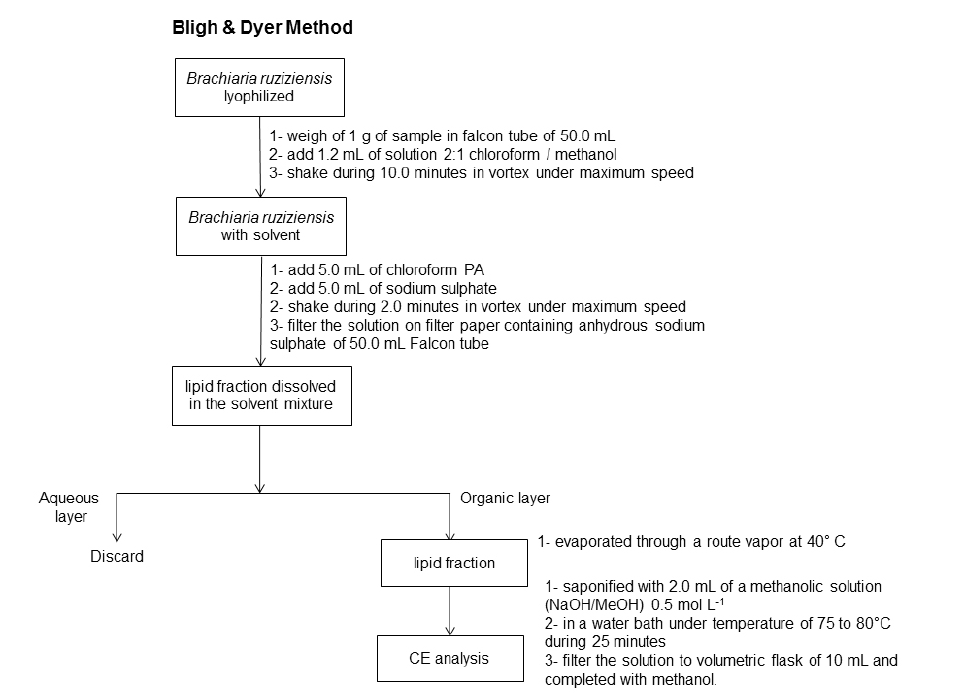
Figure 4. Bligh and Dyer extraction methods flow